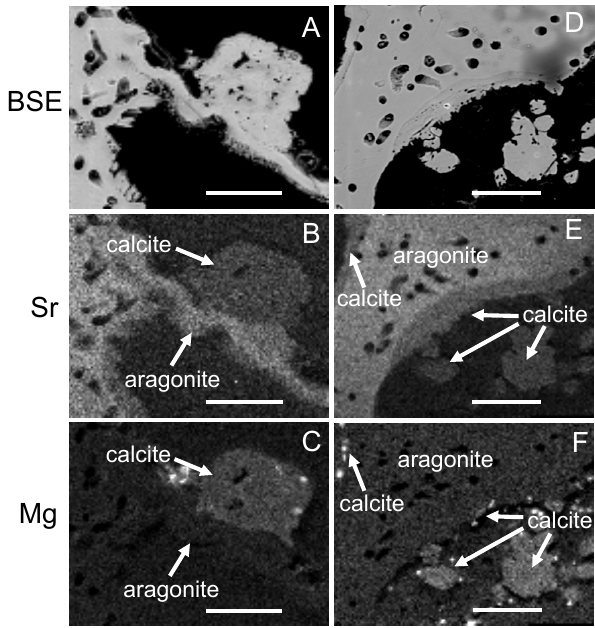
Fig. 17. Backscatter electron images (A , D) , Sr/Ca maps (B , E) and Mg/Ca maps (C , F) showing, respectively, skeletal microstruc- ture, aragonite, and calcite in two specimens of Porites cylindrica (A–C, D–F) reared for 60 days in experimental seawater that fa- vors the abiotic precipitation of calcite over aragonite (Mg/Ca=1.0). Light areas (molar Sr/Ca=0.011–0.016) of the Sr/Ca maps (B, E) correspond to aragonite in the coral skeleton, while dark areas (mo- lar Sr/Ca=0.001–0.005) correspond to calcite. Light areas (molar Mg/Ca=0.03–0.04) of the Mg/Ca maps (C, F) correspond to calcite in the coral skeleton, while dark areas (molar Mg/Ca=0.004–0.008) correspond to aragonite. Aragonite typically incorporates about an order of magnitude more Sr 2 + in its crystal lattice than does cal- cite, while calcite incorporates about one order of magnitude more Mg 2 + in its crystal lattice than does aragonite. These characteristics make Sr/Ca and Mg/Ca reliable proxies for mapping the distribution of aragonite and calcite, respectively, within coral skeletons. Scale bars are 100µm. From Ries et al.